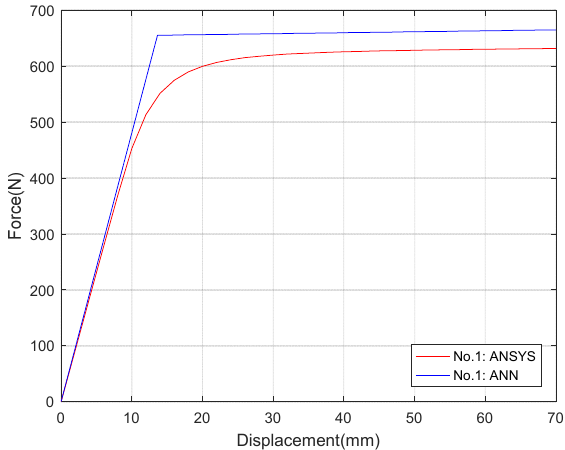
Figure 17. Estimated load–displacement curve (first coil damper).